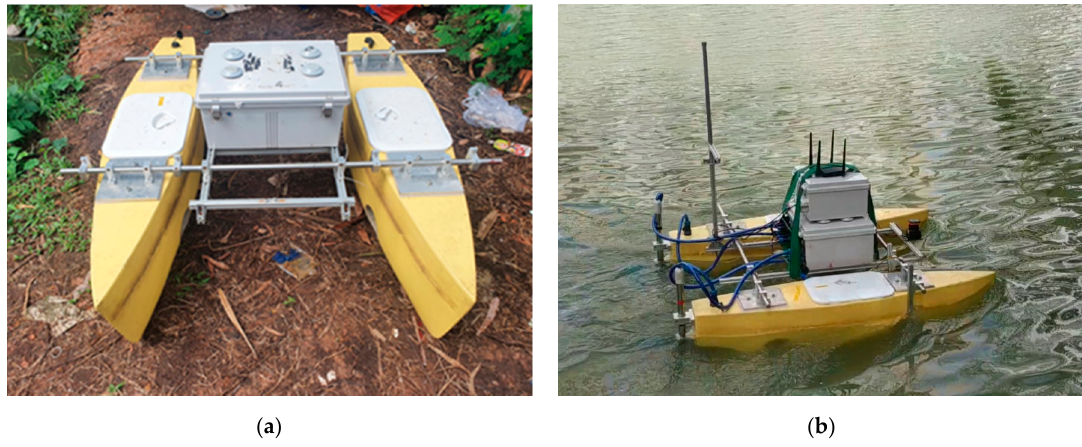
Figure 1. Catamaran design of USV2000 in ( a ); USV2000 during operation in ( b ). Table 1. Hardware specifications of USV2000.